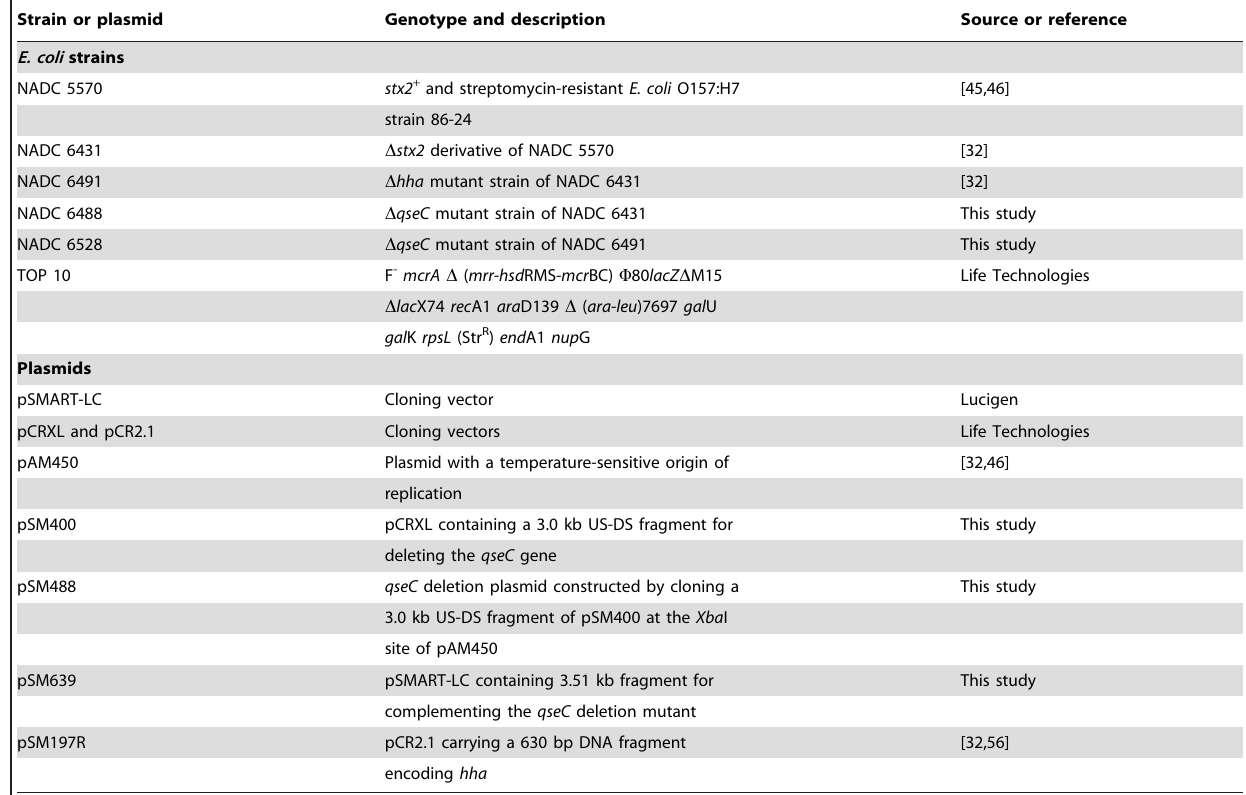
Strain or plasmid